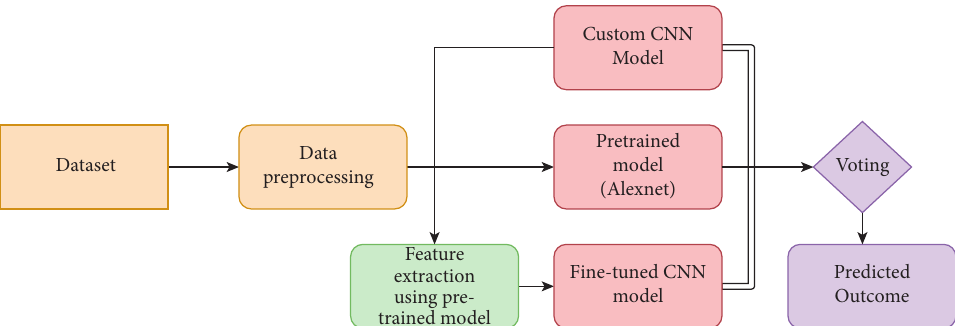
Figure 4: Overall framework of the proposed